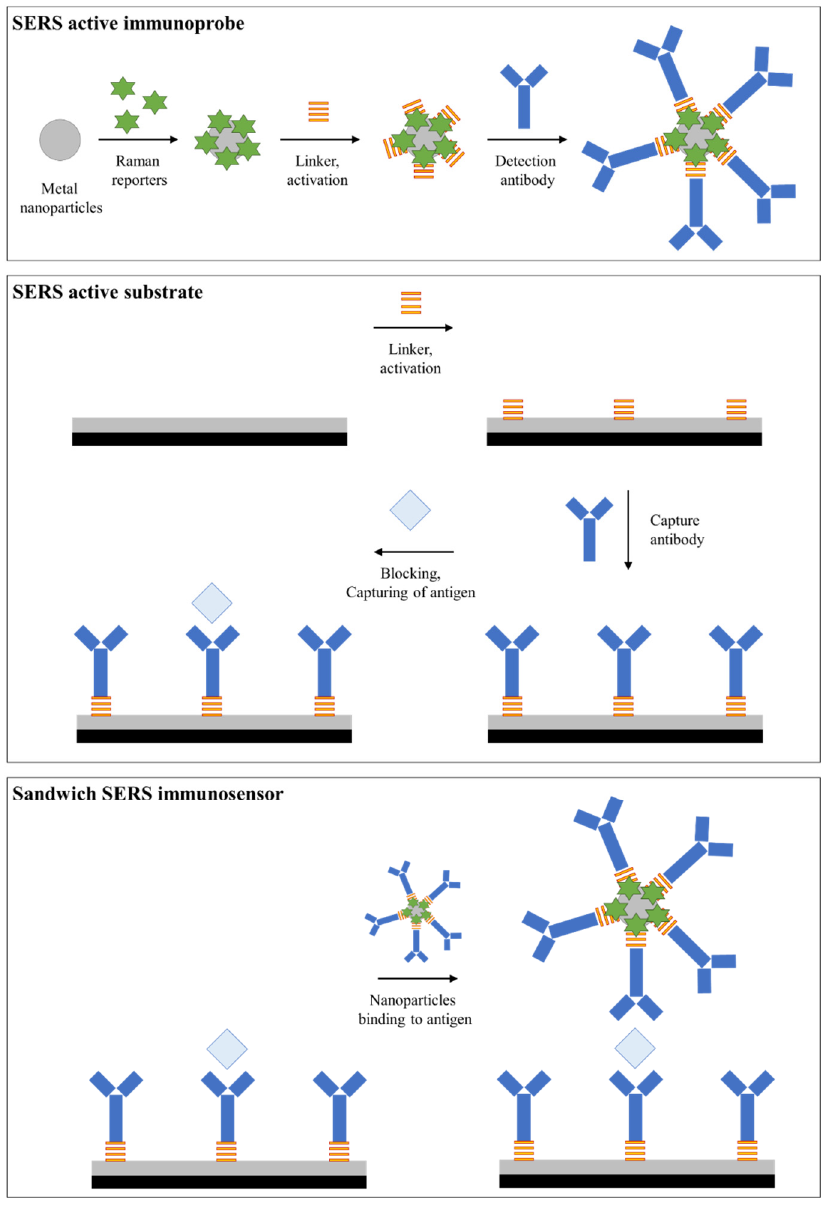
Figure 4. Diagram showing the steps of developing a sandwich-type SERS immunosensor: immunoprobe and substrate preparation, and the immunosensor functioning.